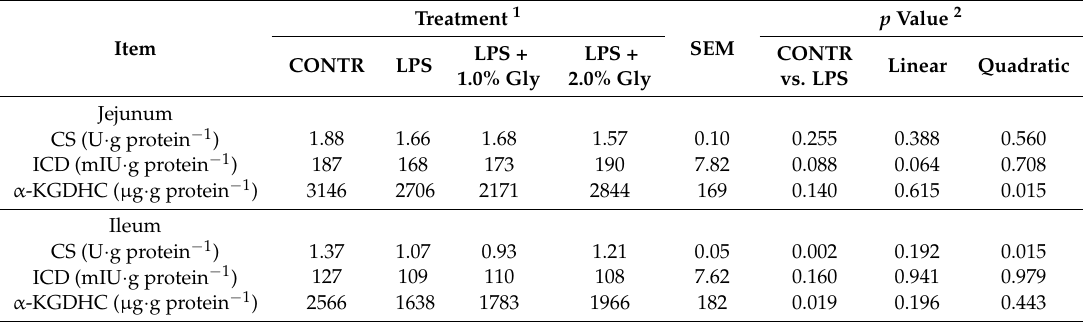
Table 4. Effects of glycine supplementation on intestinal tricarboxylic acid cycle key enzyme activities after 4 h LPS challenge in weaned piglets.